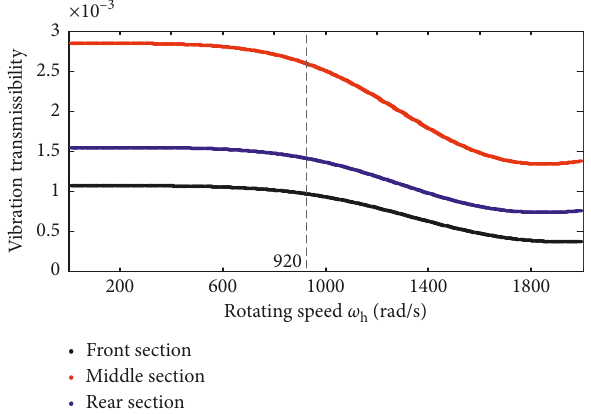
Figure 4: Vibration transmissibility ξ with varying rotating speed of high-pressure rotor ω h : front section (black), middle section (red), and rear section